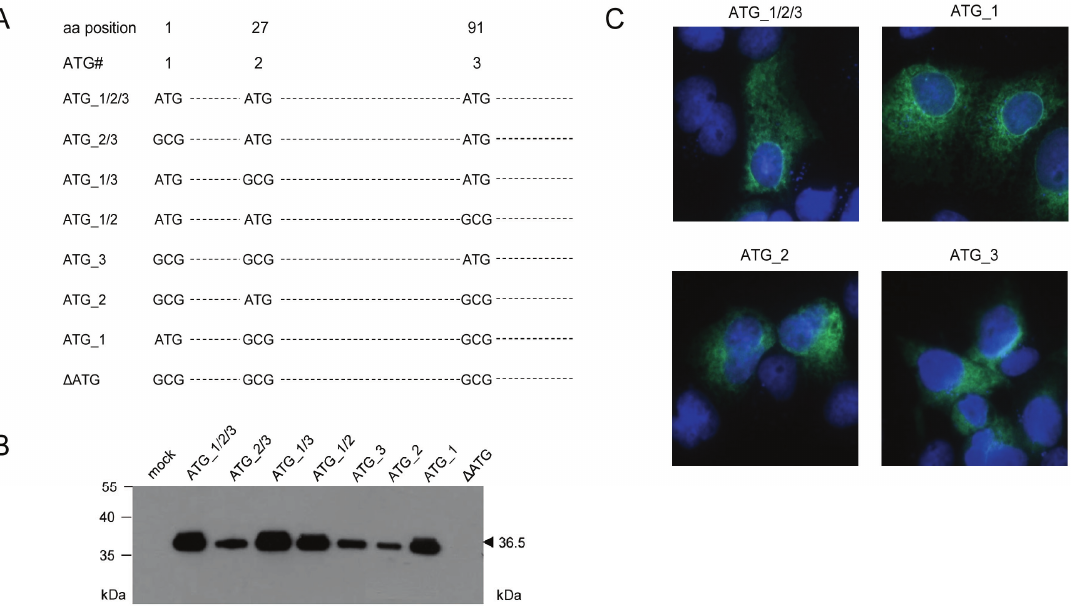
Figure 3. Mapping of AUG start codon usage by comprehensive mutational analysis through cell transfection with a complete set of expression plasmids. ( A ) Overview scheme of combinatorial ATG to GCG mutations for the three ATG codons present in the predicted ORF m164 ; ( B ) Western blot analysis of gene products of mutated m164 ORFs. COS7 cells were transfected with 4 µg of expression plasmids carrying single or combined ATG to GCG mutations at potential start sites. After 48 h, total protein was extracted and 30 µg of the protein lysates were subjected to sodium dodecyl sulfate polyacrylamide gel electrophoresis (SDS-PAGE) (12.5%) followed by Western blot analysis for detection of m164 protein species by using polyclonal antibody directed against a C -terminal peptide; ( C ) m164/gp36.5 localization in the ER, independent of usage of the 1st, 2nd, or 3rd AUG as start codon. COS7 cells were seeded on glass coverslips and were transfected with 0.4 µg of pcDNA_m164_ATG_1/2/3, _1, _2, or _3. At 24 h after transfection, cells were fixed and protein m164/gp36.5 was detected with the polyclonal antibody. DNA was stained by